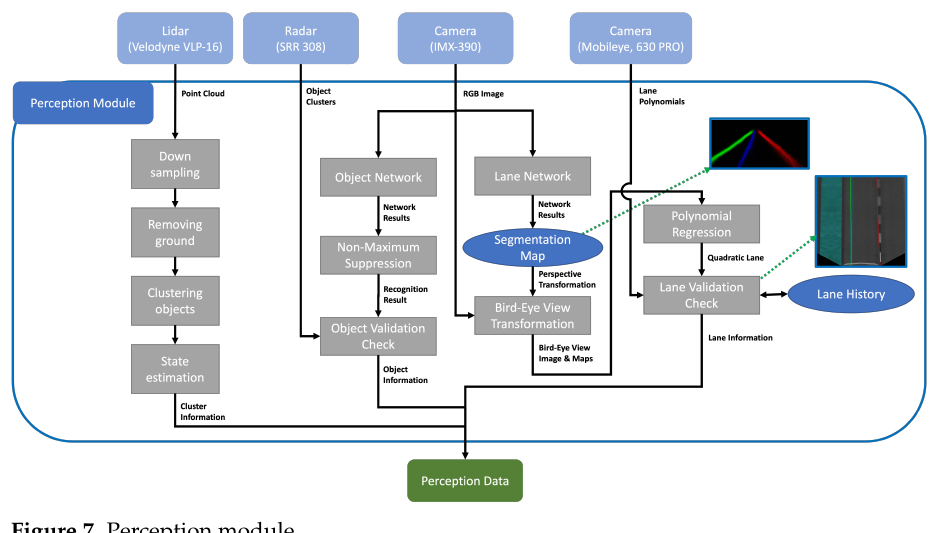
Figure 7. Perception